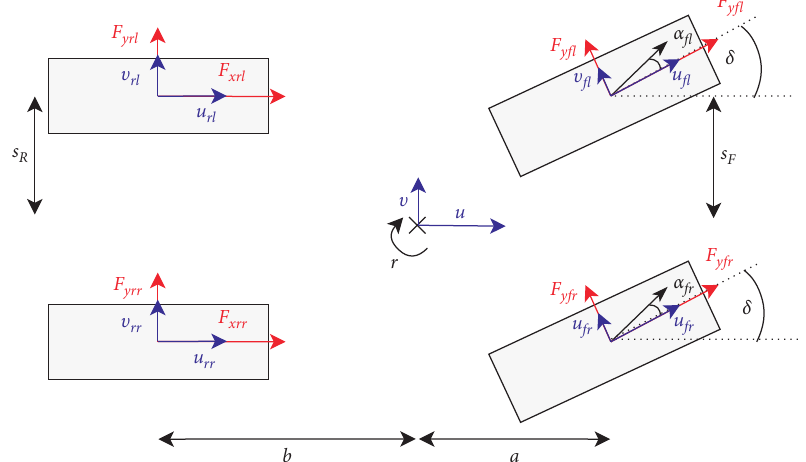
Figure 1: The four wheels two-track model of the